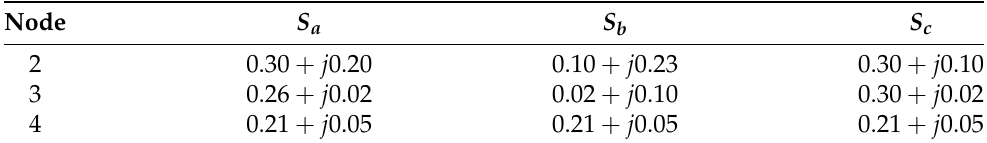
Table 2. Active and reactive power